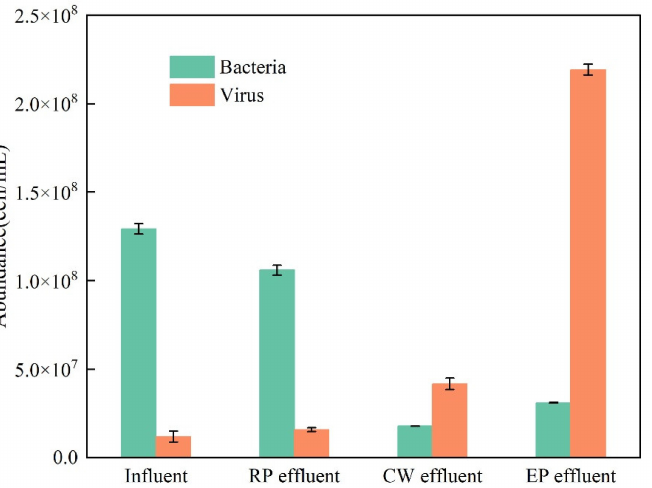
Figure 6. Changes in the abundance of bacteria and viruses at different treatment stages (RP: regulation pool; CW: constructed wetland; EP: ecological